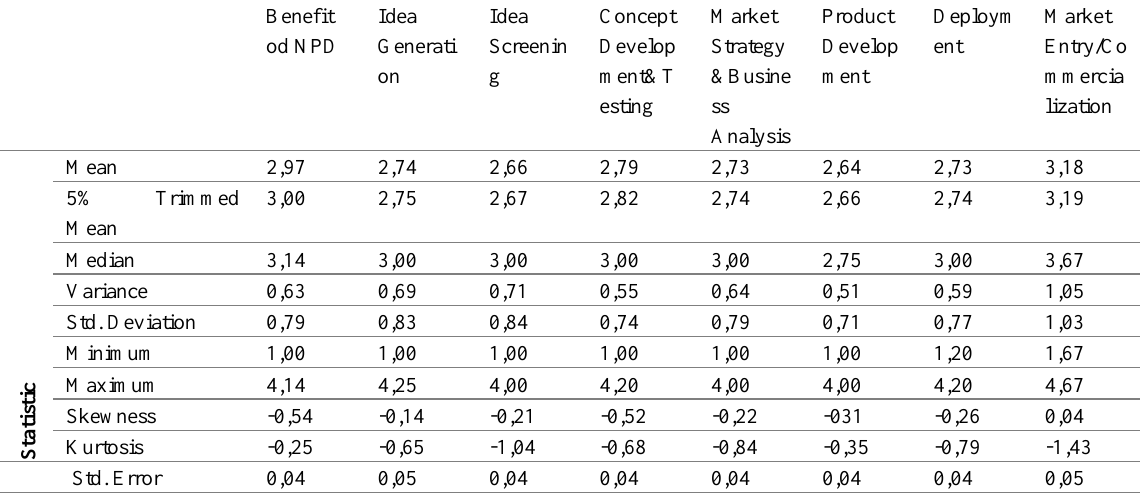
Table 5: Descriptive Statistical Indicators of Npd Benefit and Npd Process (7 Phases)